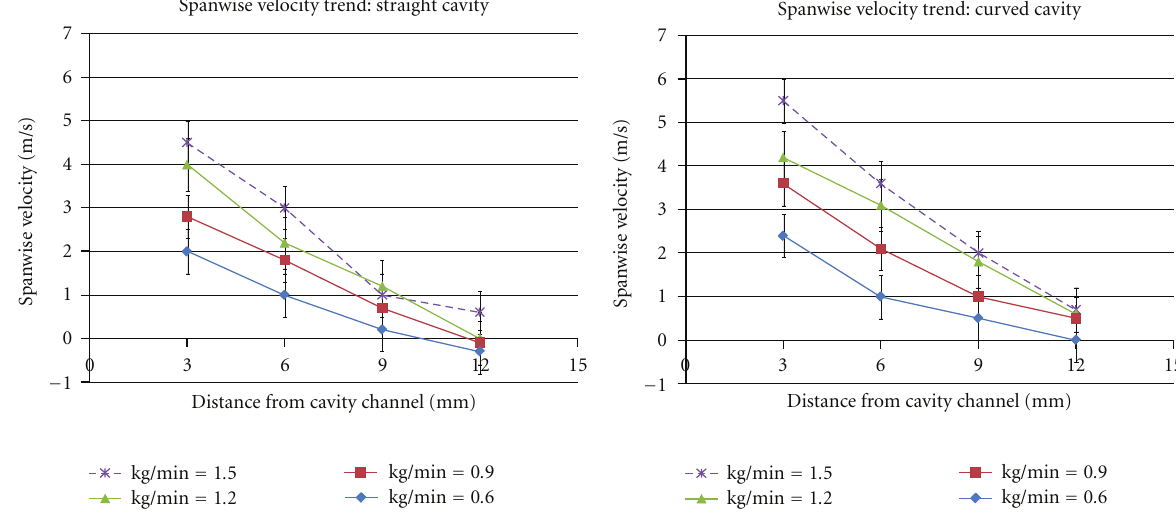
Figure 14: Mean spanwise (U) velocity as a function of depth within the main